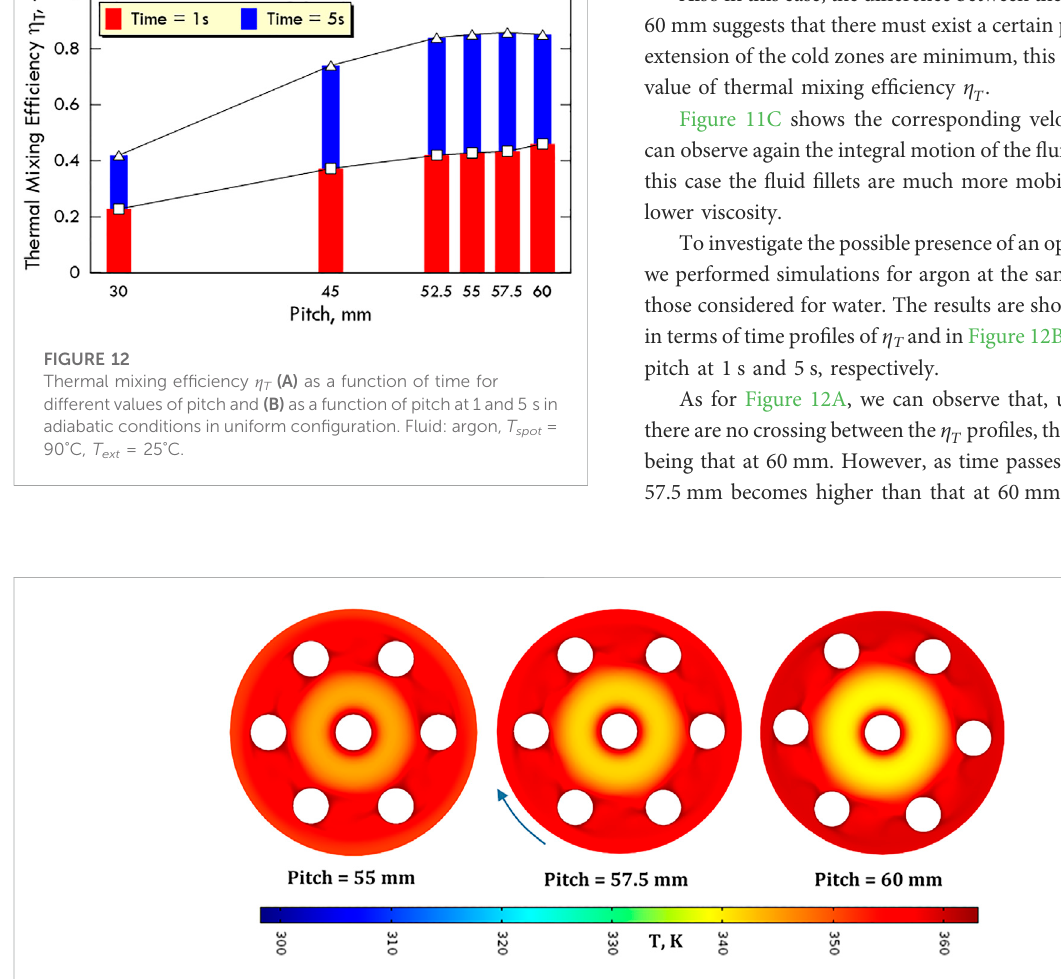
FIGURE 13 Temperature pro fi les at 5 s for different pitch values in adiabatic conditions in uniform con fi guration. Fluid: argon, T spot = 90 ° C, T ext = 25 °